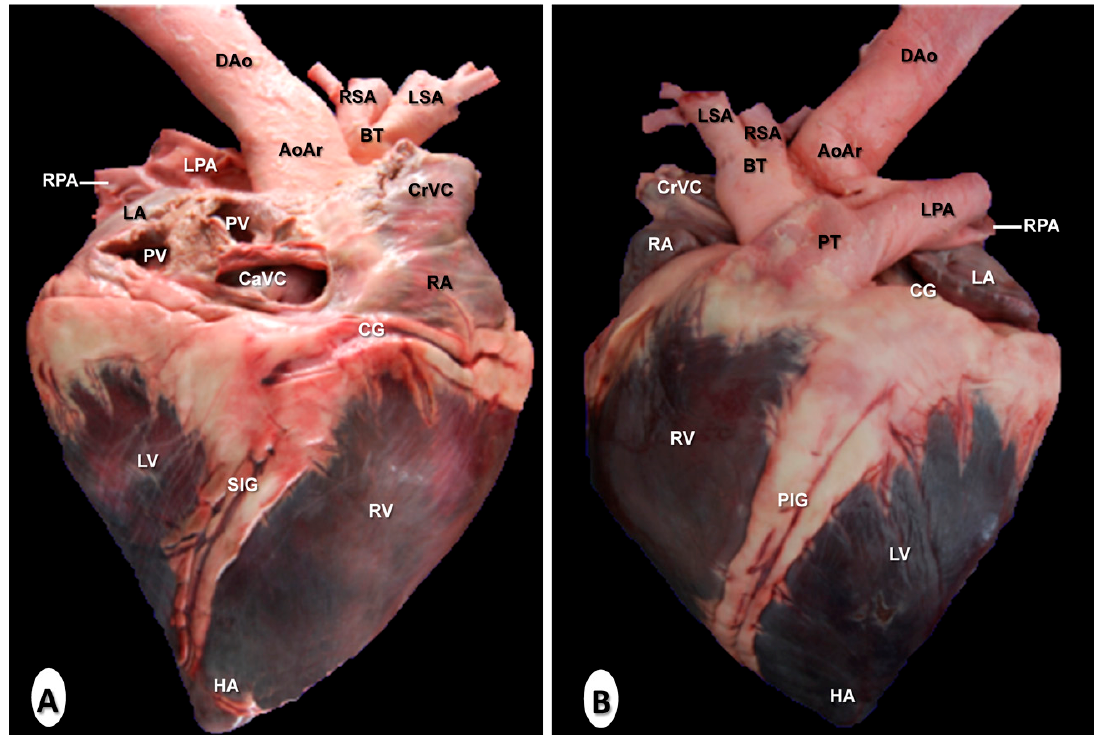
Figure 8 . Anatomical dissections of the heart. ( A ) Atrial surface and ( B ) auricular surface. Aortic arch (AoAr); brachiocephalic trunk (BT); caudal vena cava (CaVC); cranial vena cava (CrVC); descending aorta (DA); heart apex (HA); left atrium (LA); left pulmonary artery (LA); left subclavian artery (LSA); left ventricle (LV); paracoronary interventricular groove (PIG); pulmonary trunk (PT); pulmonary vein (PV); right atrium (RA); right pulmonary artery (RPA); right subclavian artery (RSA); subsinuosal interventricular groove (SIG); and right ventricle (RV).